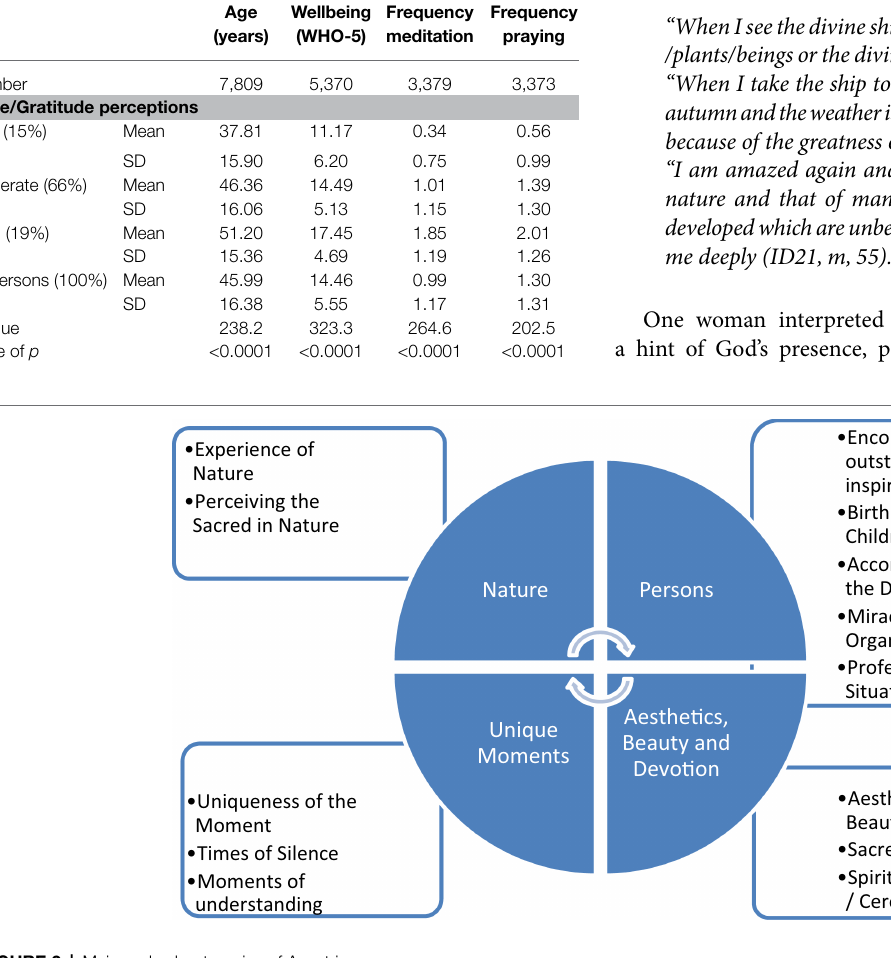
FIGURE 2 | Main and subcategories of Awe triggers.